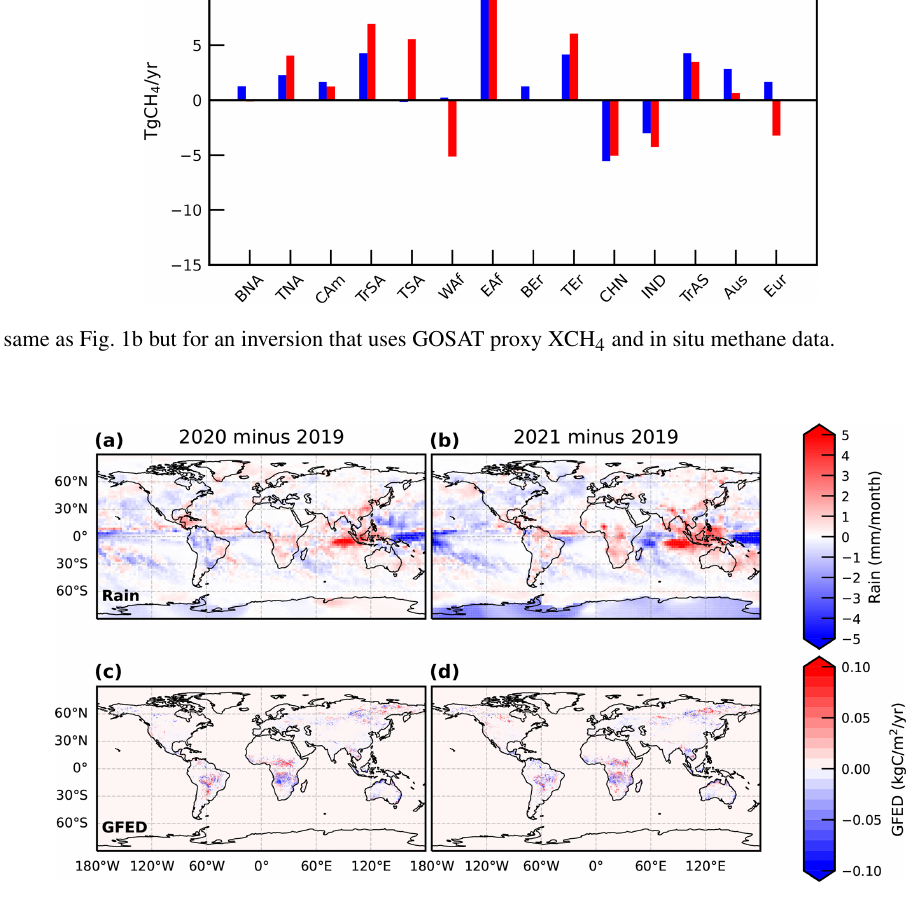
Figure A7. Global annual mean NOAA CMAP precipitation (mmmonth − 1 yr − 1 ) and GFED fire emission (kgCm − 2 yr − 1 ) anomalies in (a, c) 2020 and (b, d) 2021 relative to values in